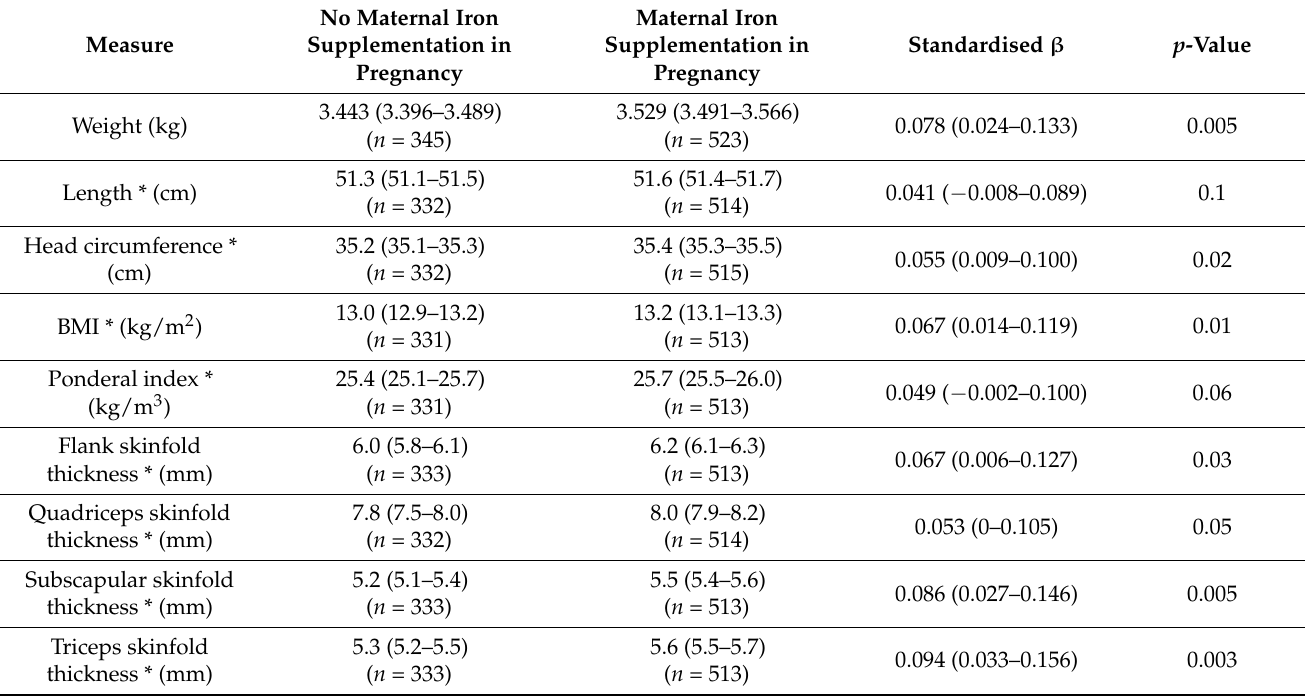
Table 3. Associations between iron supplementation status in pregnancy and indices of offspring size at